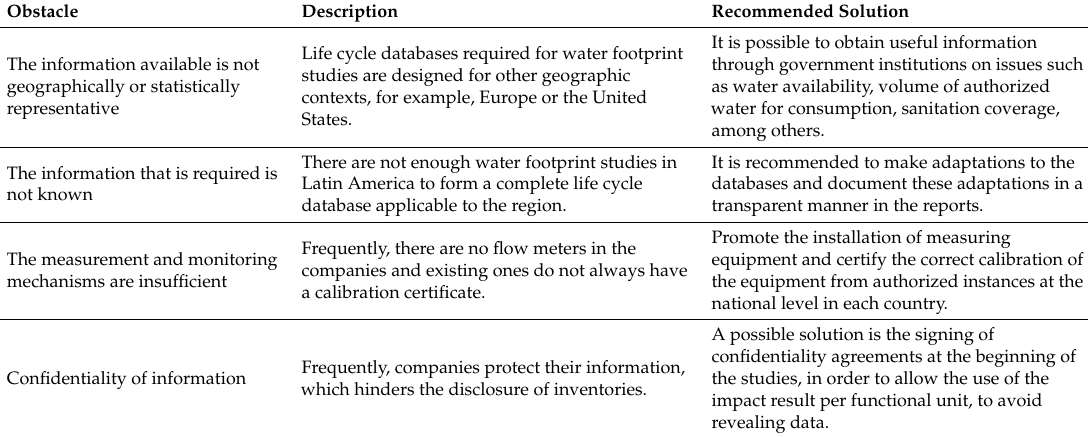
Table 3. Main obstacles to collect data for water footprint studies in Latin America and recommended solutions. Modified from CADIS-COSUDE (2016)